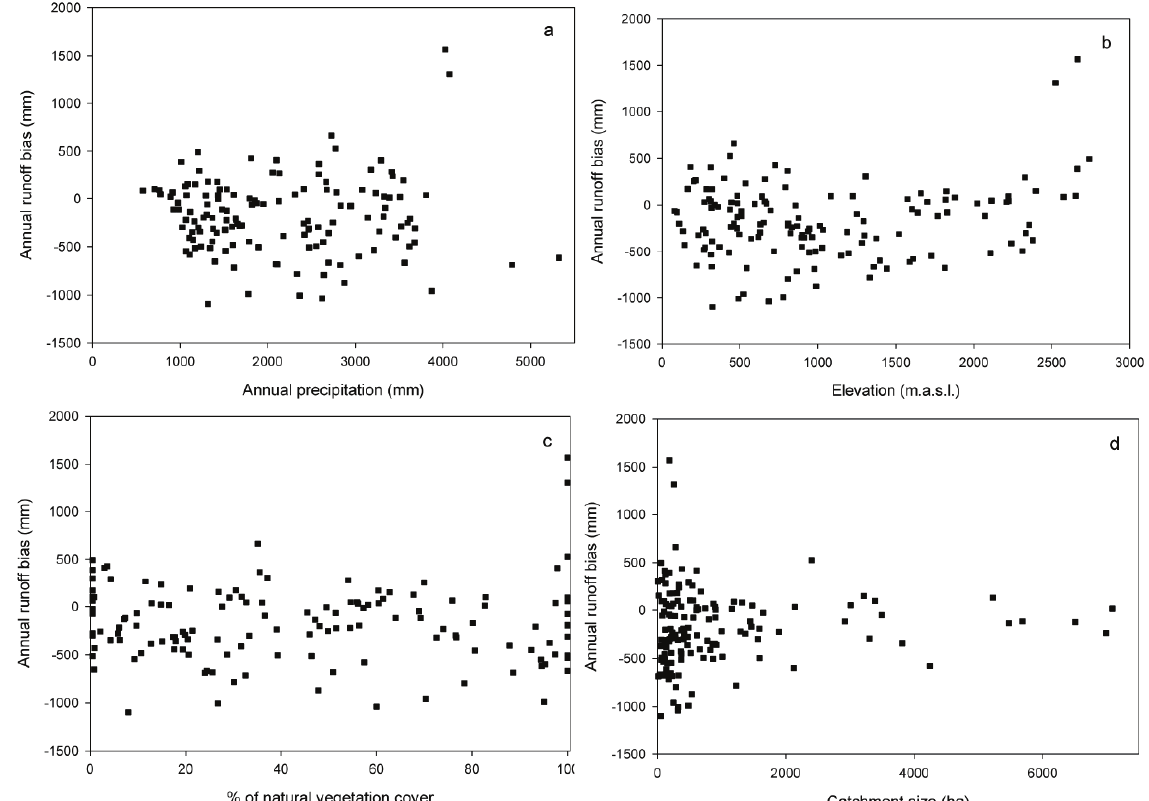
Fig. 5. Residual distributions of annual runoff according to catchment annual precipitation (a) , average elevation (b) , percentage of natural vegetation cover (c) , and size (d) . Each dot corresponds to the difference between MAPSS-modelled and observed annual runoff for each catchment.